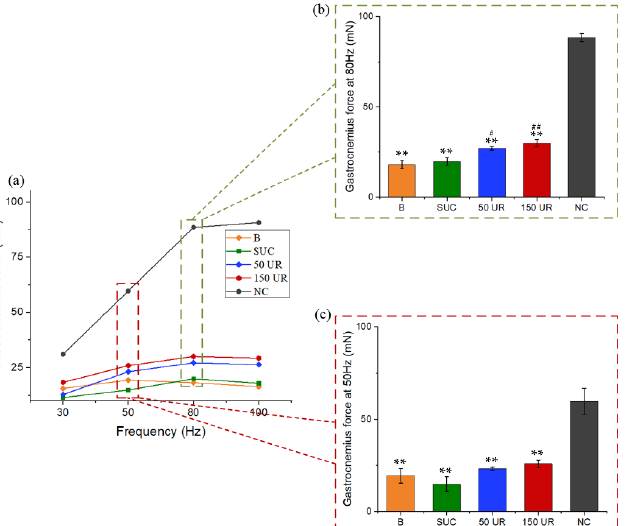
Figure 5. ( a ) The force–frequency relationship of five groups. ( b ) The gastrocnemius force induced by LIPUS stimulation at 50 Hz. ( c ) The gastrocnemius force induced by LIPUS stimulation at 80 Hz. The data are expressed as mean ± SE ( n = 5 in each group). ** p < 0.01 vs. NC group, ## p < 0.01 vs. B group, # p < 0.05 vs. B